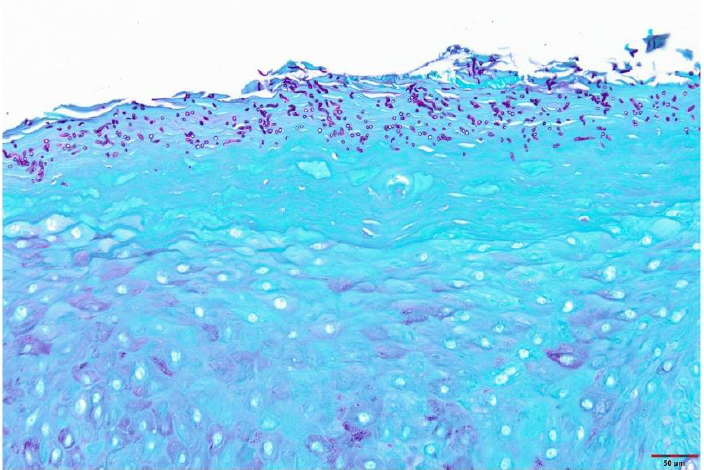
Figure 2. Panel shows image from one tissue specimen stained with PAS to show presence of Candida albicans . Scale bar: 50 μm.